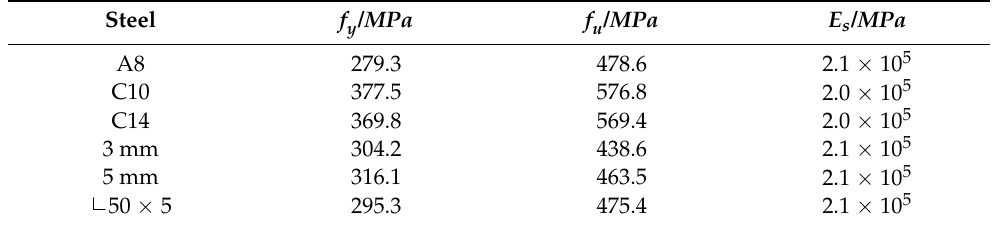
Figure 1. Details of DVFP specimen. Table 1. Material properties test results of steel. Table 1. Material properties test results of steel.